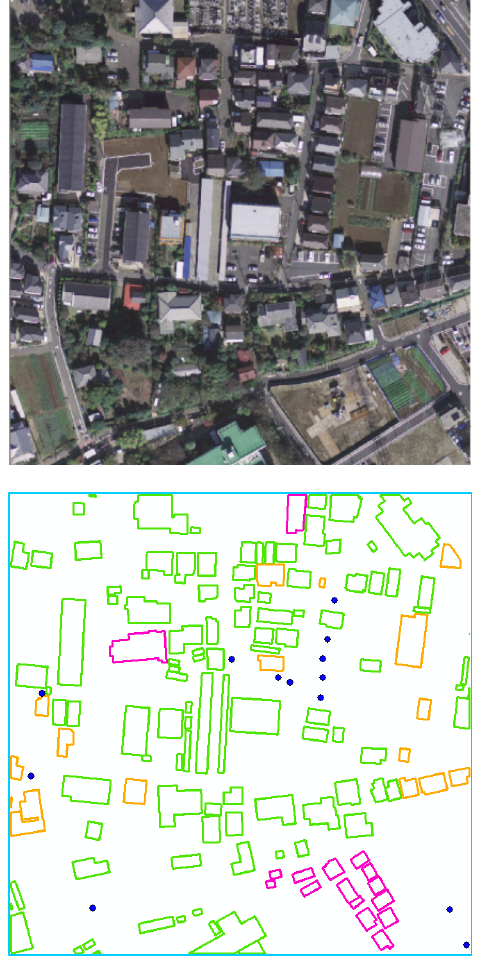
Figure 3. Image and change detection results in a test area (Blue: Newly-built, Pink: Demolished, Orange: Reconstructed)